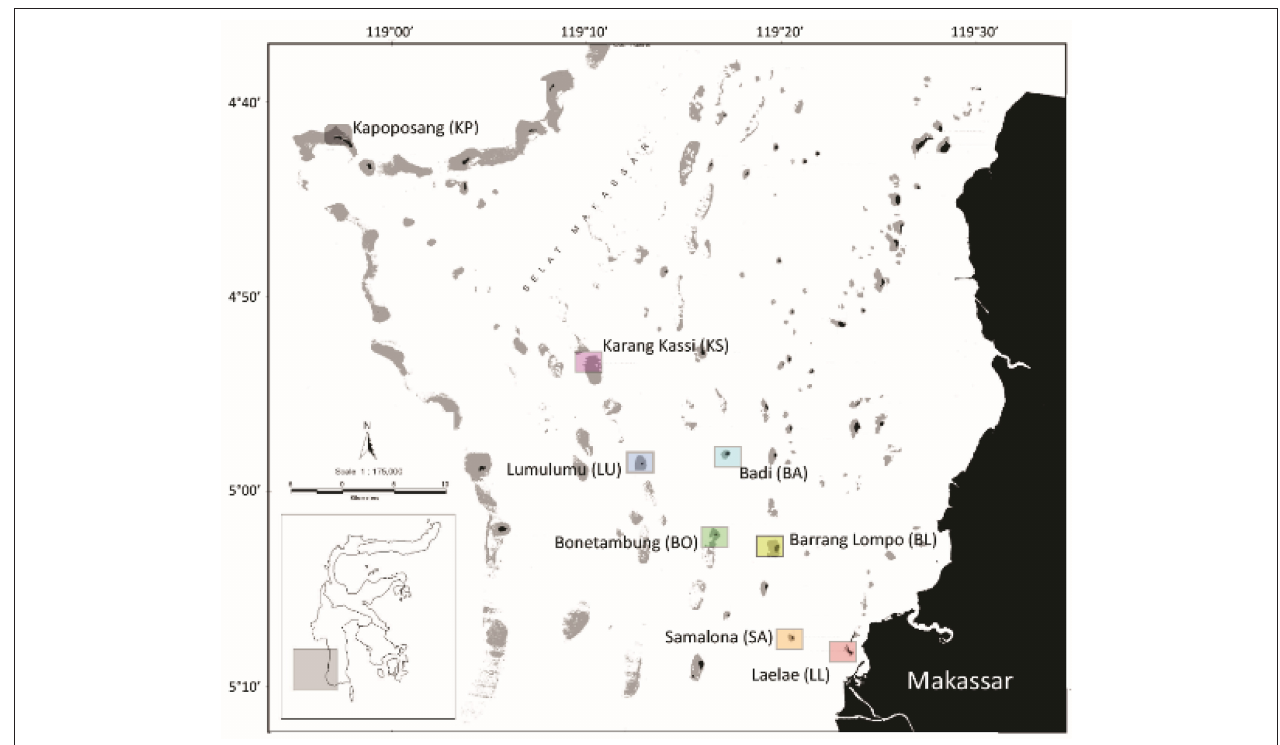
FIGURE 1 | Map of the Spermonde Archipelago, Indonesia indicating the sampling